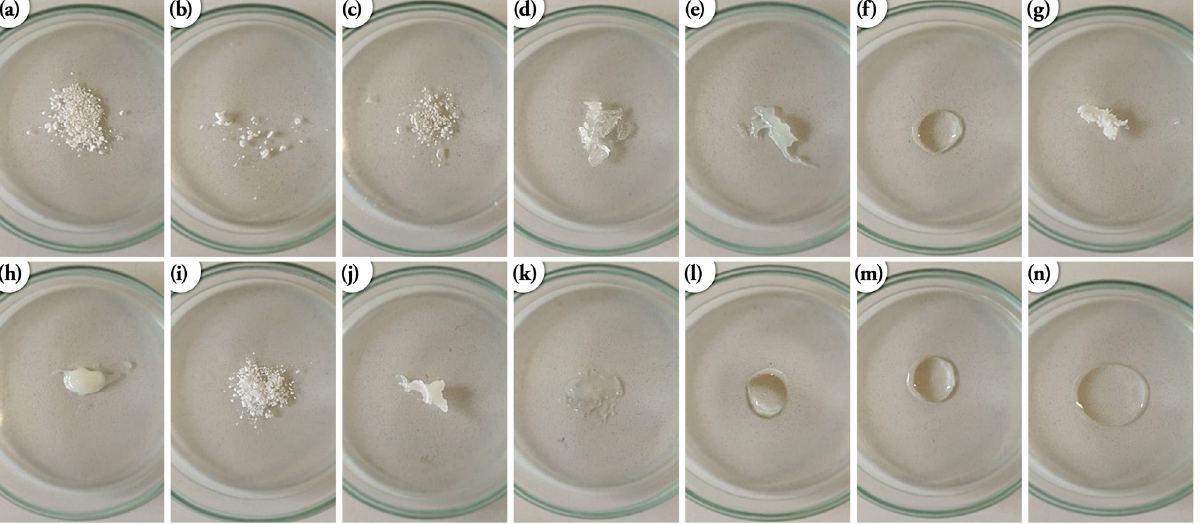
Figure 5. Images of physical state of the obtained compounds ( a ) monoT 8 (F1) , ( b ) DDSQ-2Si(F1)